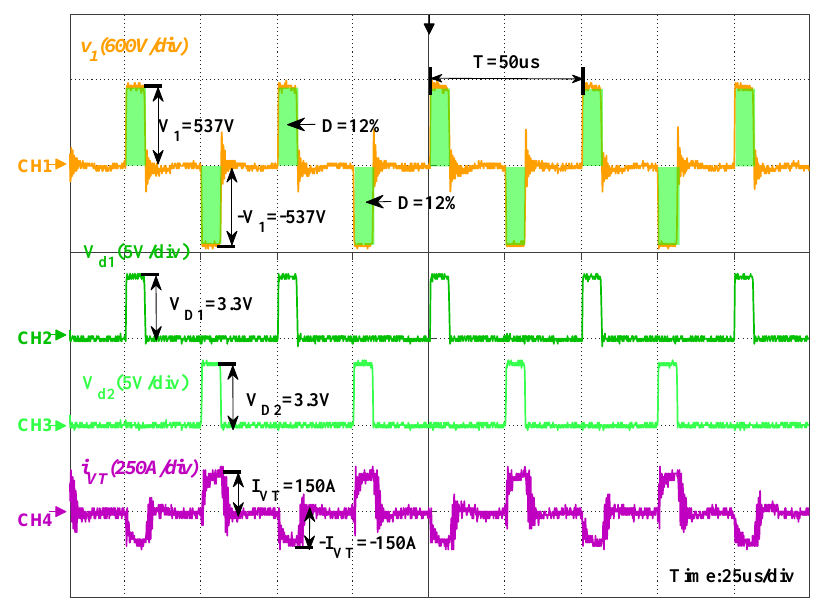
Figure 15. The key waveform of inverter without DC bias.